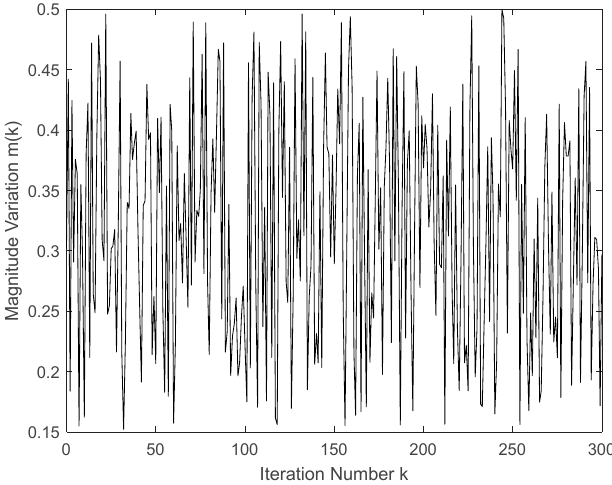
( t , k ). Figure 3. The randomly varying factor m ( k ) in y o ( t , k ) o